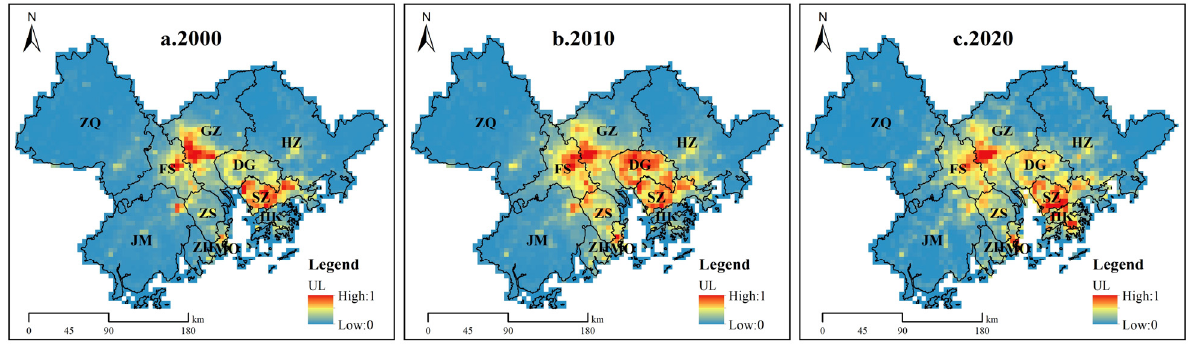
Figure 3. The spatial pattern of the UL in the GBA, 2000–2020.